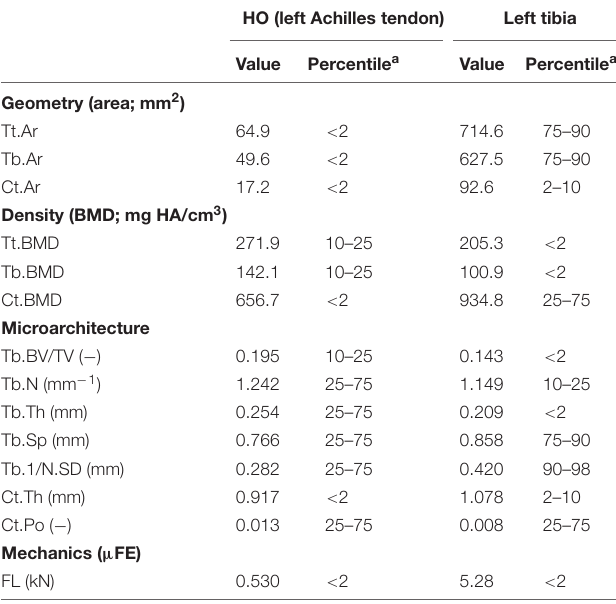
TABLE 3 | Bone parameters of the left distal tibia and isolated heterotopic ossification (HO) in the left Achilles tendon of patient 1, a 33-year old woman including normative values of the distal tibia with age- and gender-matched